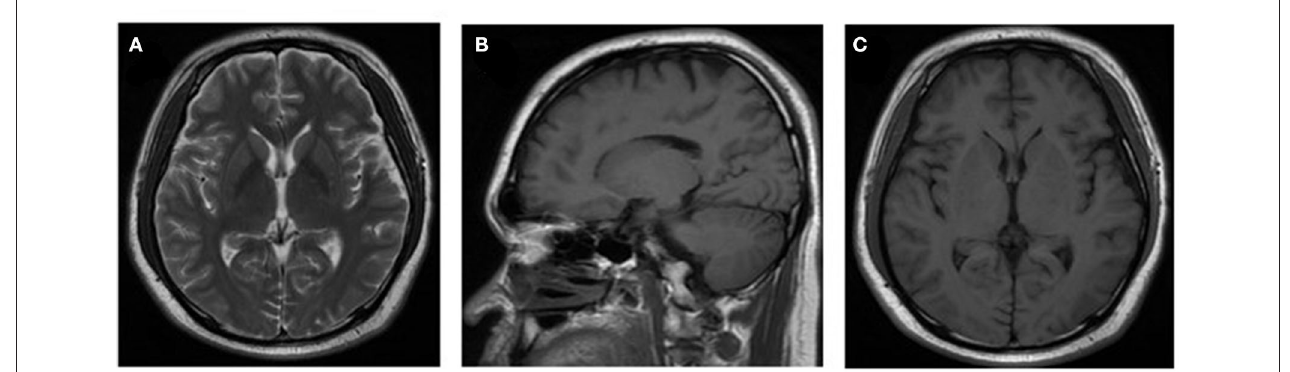
FIGURE 1 | Neuroradiologic MRI. The MRI examination results of the patient were unremarkable (images shown in pictures A–C ).